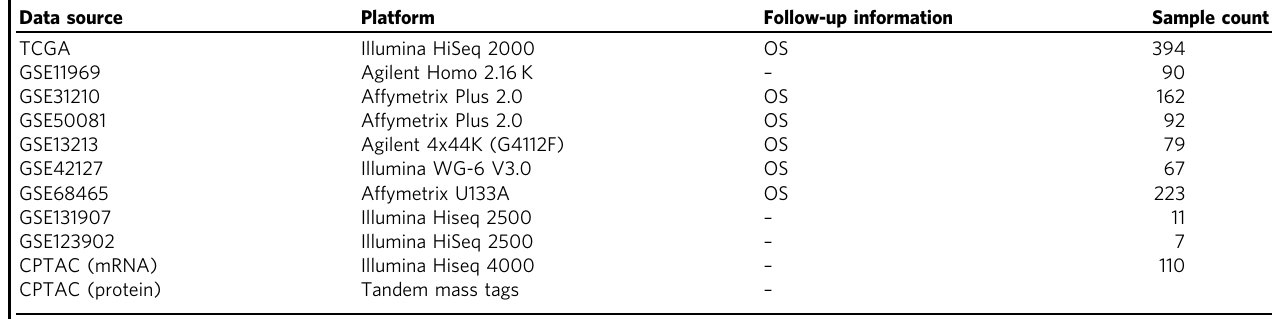
Table 1 The datasets of lung adenocarcinoma used in this